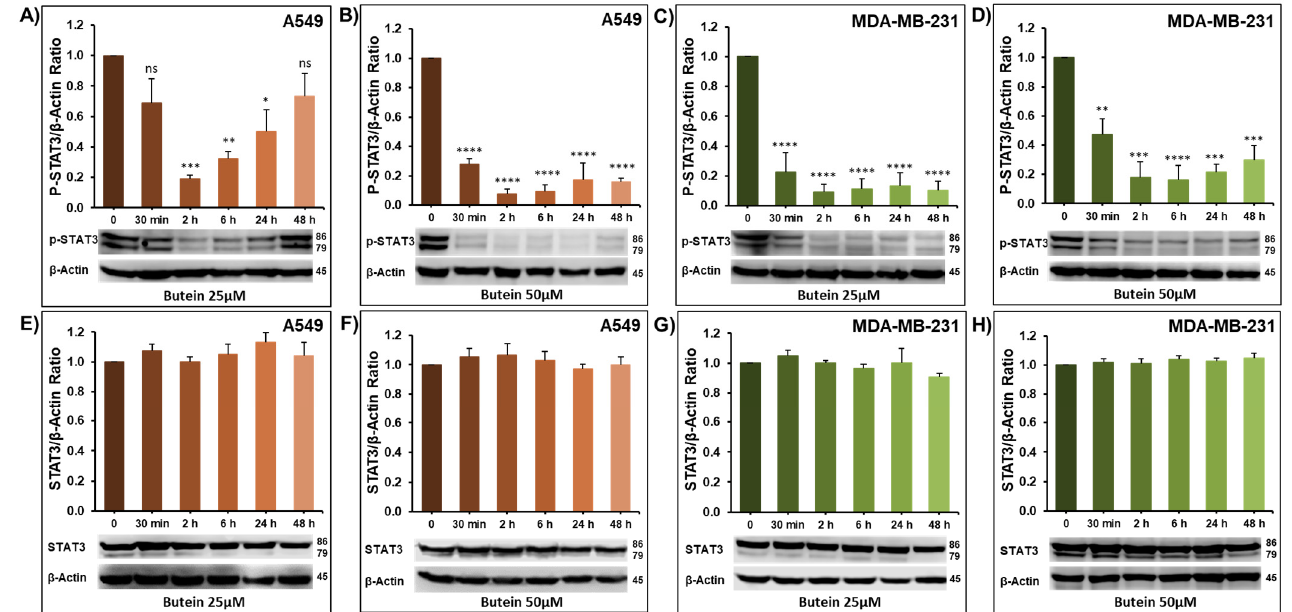
Figure 5. Western blot showing the inhibition of STAT3 phosphorylation by butein in A549 lung cancer cells ( A , B ), and MDA-MB-231 breast cancer cells ( C , D ). Effect of butein on total STAT3 ( E – H ). Each cell line was treated with 25 and 50 µM butein, and proteins were extracted at the indicated time-points (0.5, 2, 6, 24, and 48 h). β -actin was used as a loading control. The data shown are representative of three independent experiments. Columns represent means; bars represent S.E.M. * Significantly different at p < 0.05, ** Significantly different at p < 0.01, *** Significantly different at p < 0.001, **** Significantly different at p < 0.0001. ns—non-significant.